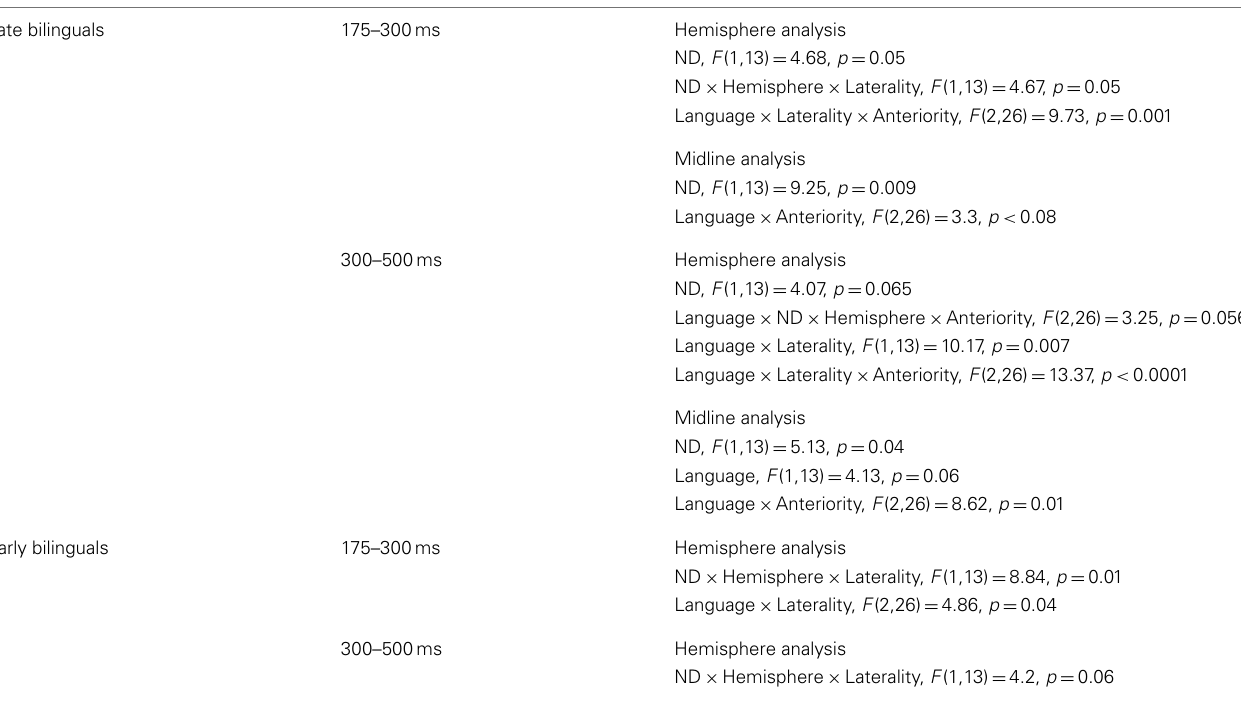
Table 1 | Relevant findings for late and early bilinguals in analyses at central, centroparietal, and parietal